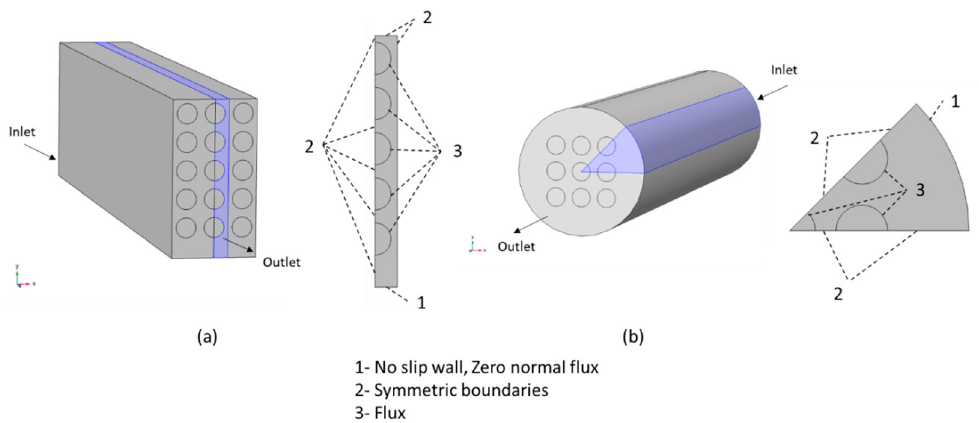
Figure 2. Boundary conditions used in the model: ( a ) planar bundle; ( b ) circular